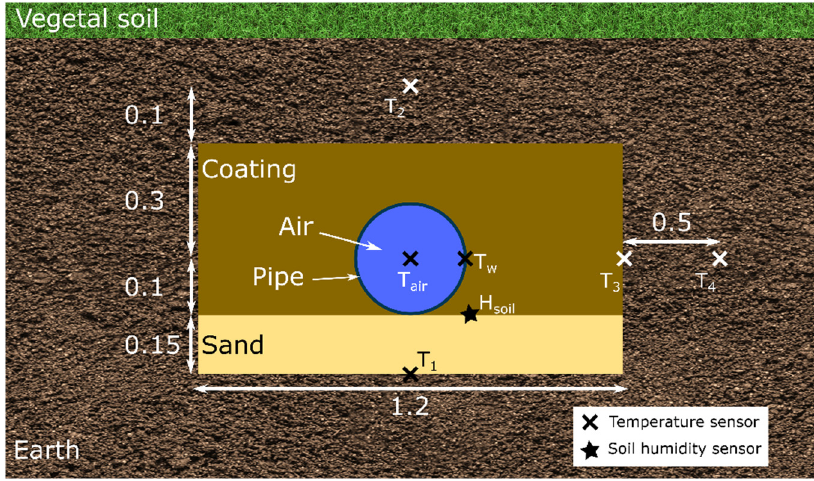
Figure 2. System layers and positions of sensors. All dimensions are in meters. Table 1. Pipe characteristics. Table 2. Characteristics of the EAHE